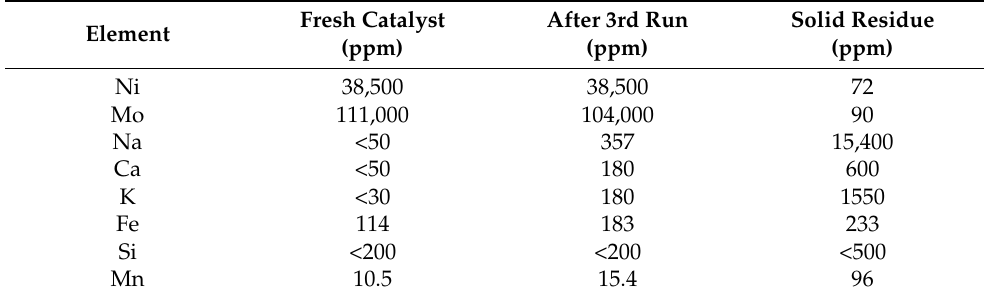
Table 2. Elemental analysis of the NiMo/Al 2 O 3 catalyst before the hydrotreatment, after the 3rd run, and the solid residue generated after the 3rd consecutive run.